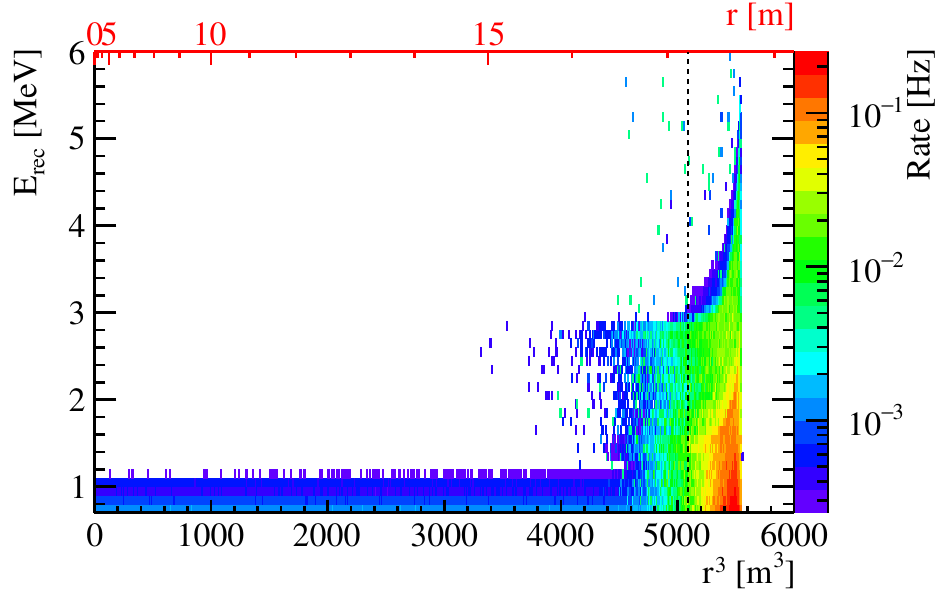
Figure 8. The singles event rate as a function of volume (bottom X-axis) or radius (top X-axis) and reconstructed energy E (Y-axis). The default FV radius cut is shown as the dashed line. rec